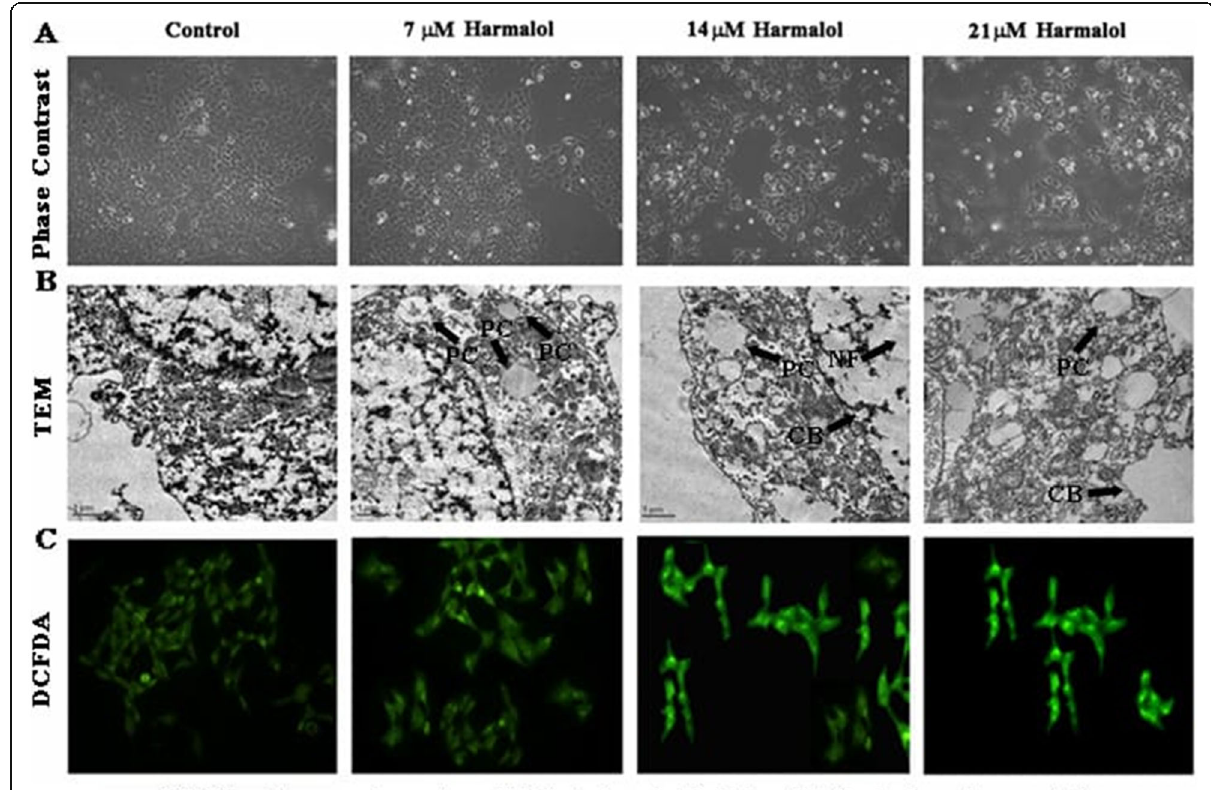
Fig. 2 a Phase-contrast microscopic images, b changes of membranes of HepG2 cells in TEM, and c ROS generation study by DCFH-DA under a fluorescent microscope (× 200). Abbreviations are represented below the images